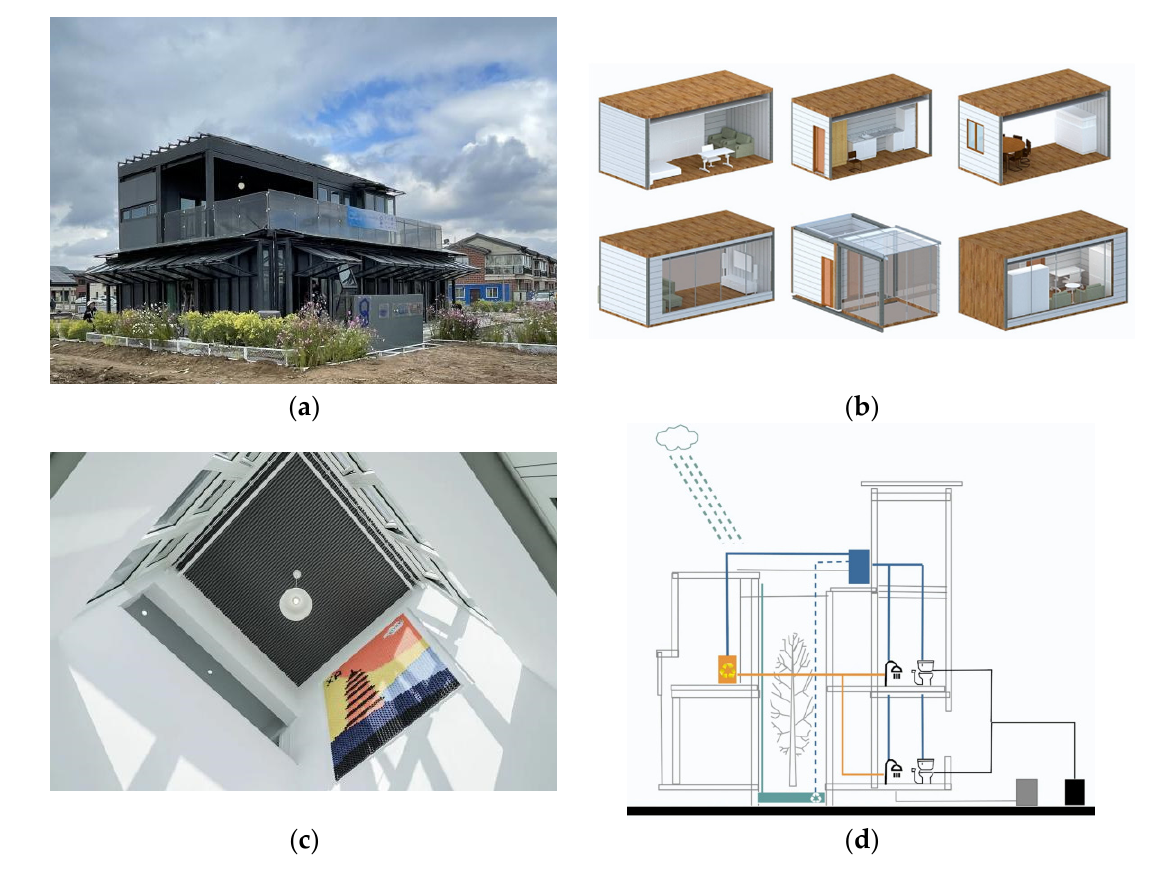
Figure 17. Main results of the Qiju 3.0. ( a ) Prefabricated building. ( b ) Changeable modules. ( c ) Indoor atrium. ( d ) Water purification system.